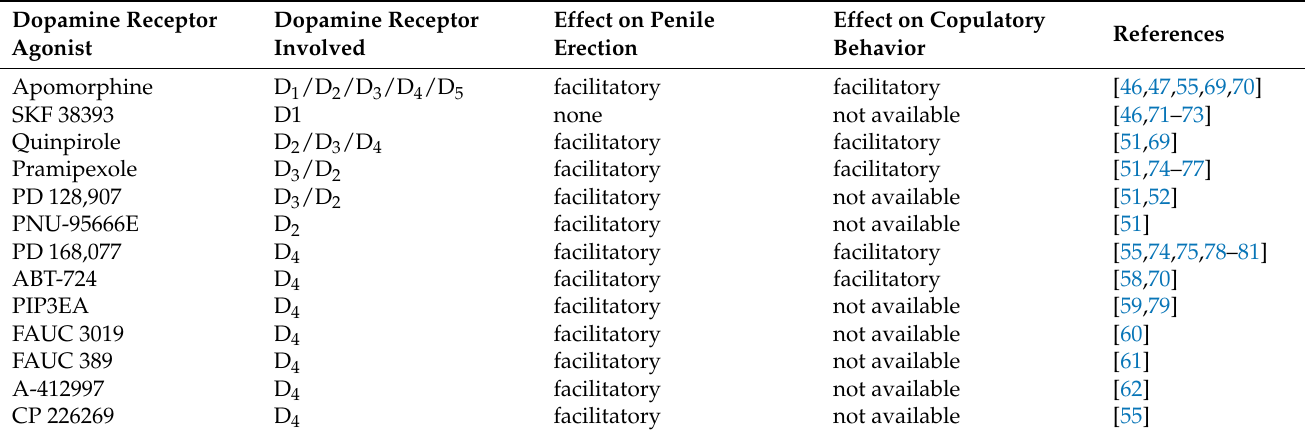
Table 4. Effect of old and new dopamine receptor agonists on penile erection and copulatory